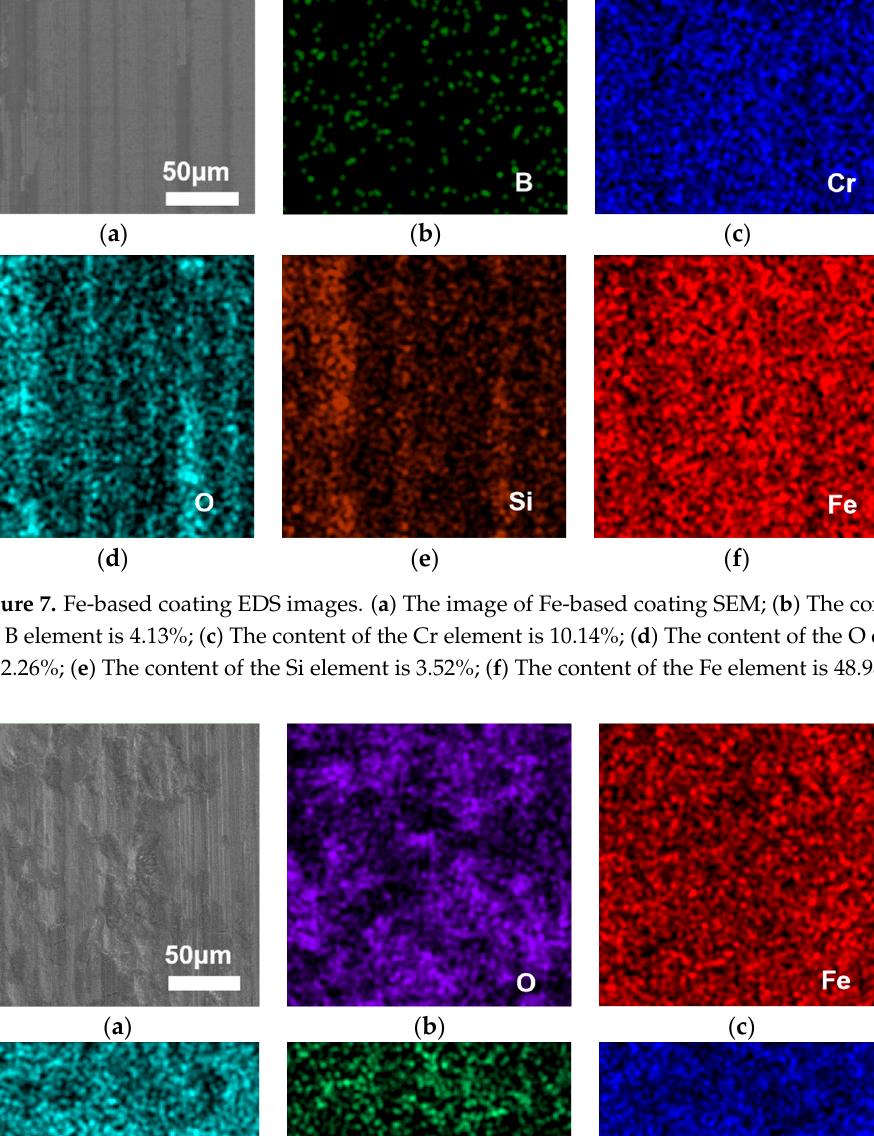
Figure 8. Ni-based coating EDS images. ( a ) The image of Ni-based coating SEM; ( b ) The content of the O element is 32.97%; ( c ) The content of the Fe element is 10.54%; ( d ) The content of the Ni element is 21.52%; ( e ) The content of the C element is 22.97%; ( f ) The content of the Cr element is 8.41%.